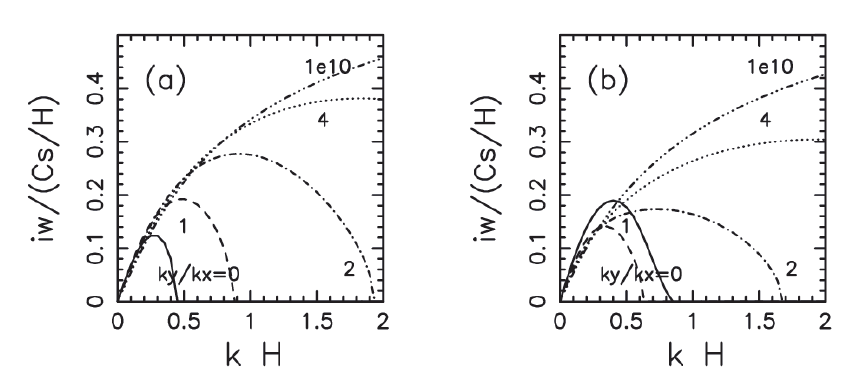
Figure 15: Growth rates of different modes for the magnetic buoyancy instability of an isolated flux sheet. Here 𝑘 𝑥 and 𝑘 𝑦 are the wavenumbers parallel and perpendicular to the magnetic field. The case 𝑘 𝑦 /𝑘 𝑥 = 0 represents the pure undular mode while 𝑘 𝑦 /𝑘 𝑥 → ∞ represents the interchange mode. The left panel shows the growth rates for the case without magnetic shear (in the vertical direction) while the right panel shows the corresponding growth rates with magnetic shear. Image reproduced with permission from Nozawa (2005), copyright by